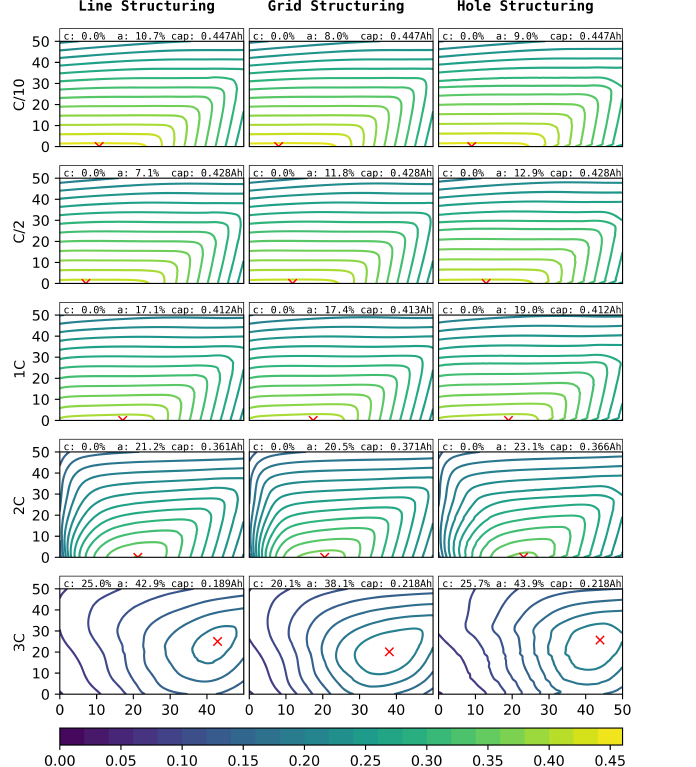
Figure 5. Discharge capacities [Ah] for full cells with line (left, pitch = 200µm), grid (centre, pitch = 200µm), and hole (right, pitch = 70µm) structures, for C-rates C/10–3C. The x-axis shows the degree of ablation as a percentage of the anode, the y-axis for the cathode. At the top of each plot, the optimal degree of ablation for the cathode and anode and the corresponding discharge capacity are